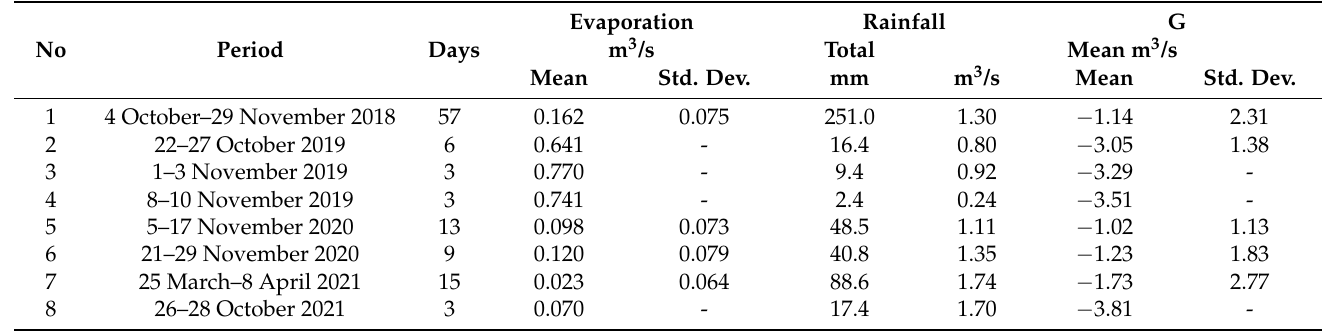
Table 2. Periods, day length, rainfall and calculated results of evaporation E and net groundwater inflow G. Evaporation